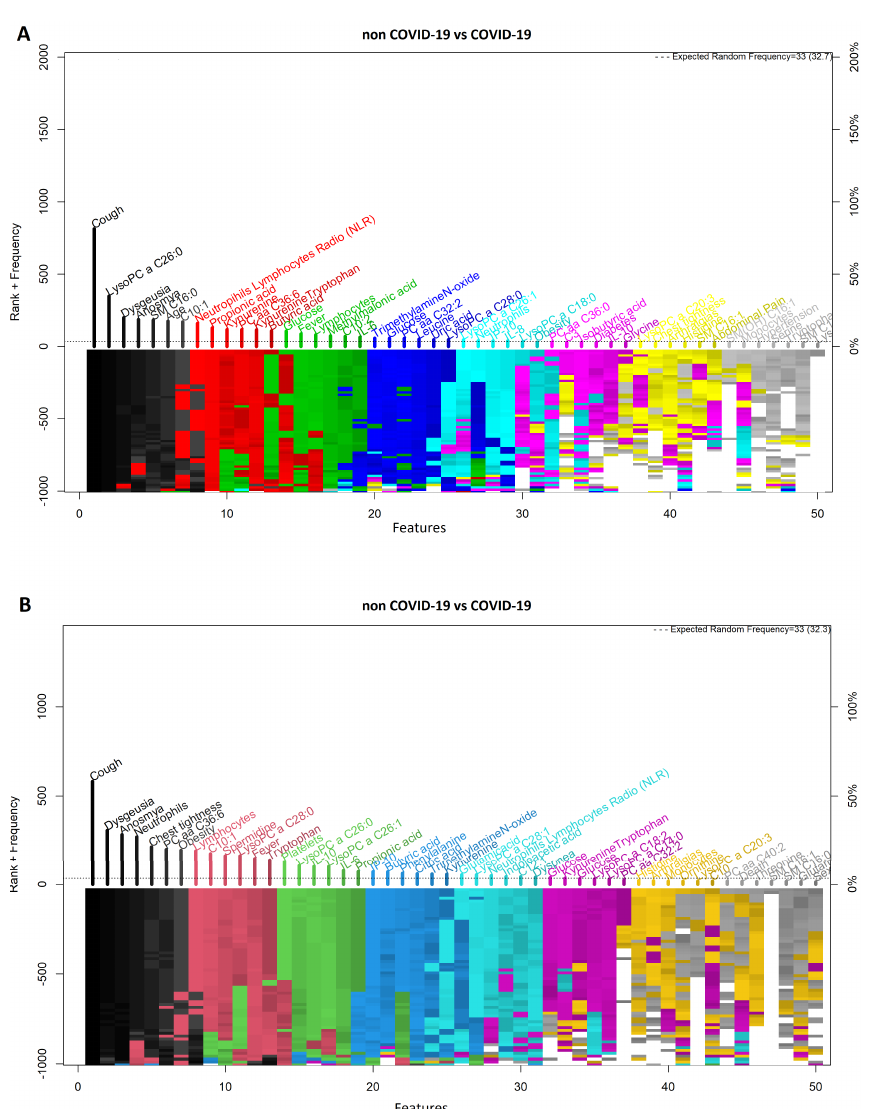
Figure A1. Feature–rank stability in 1000 models, for the classification of COVID-19 ( A ) Logistic regression model ( B ) Support Vector Machine model.The ”y positive” axis shows the number of times each feature was included in a given model (the frequency ranking). The ”y negative” axis shows the color coded rank of each feature as each model was generated. The ”x axis” shows the features ordered by rank. Starting color for each feature is assigned accordingly to the feature descending rank (from black down to